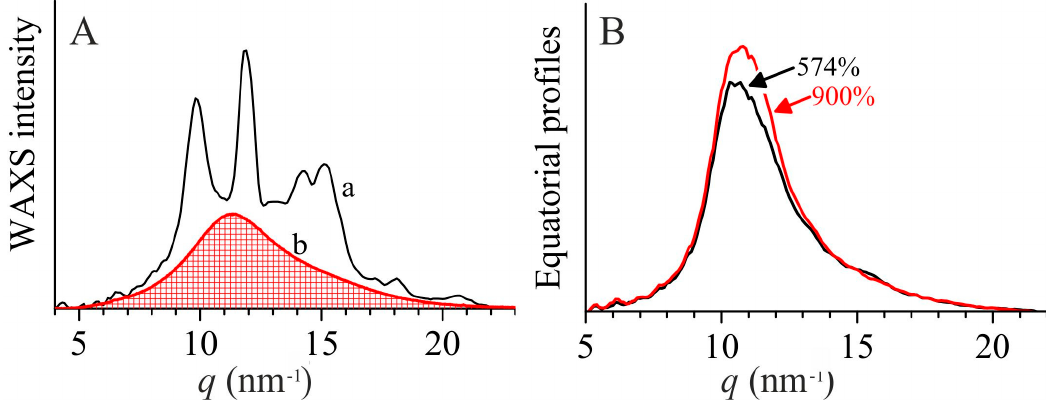
Figure 7. ( A ) Radially averaged WAXS profile of the undeformed sample iPP-5.9, extracted from the bidimensional WAXS image a of Figure 1A (a) and underlying amorphous contribution, approximated by the diffraction profile of an atactic polypropylene (b). ( B ) Equatorial profiles extracted from the bidimensional WAXS images of Figure 1B, of the sample iPP-11.0 stretched at 574 and 900% deformations. The diffraction curves are subtracted for the background contribution, approximated as a straight line subtending the whole profiles.